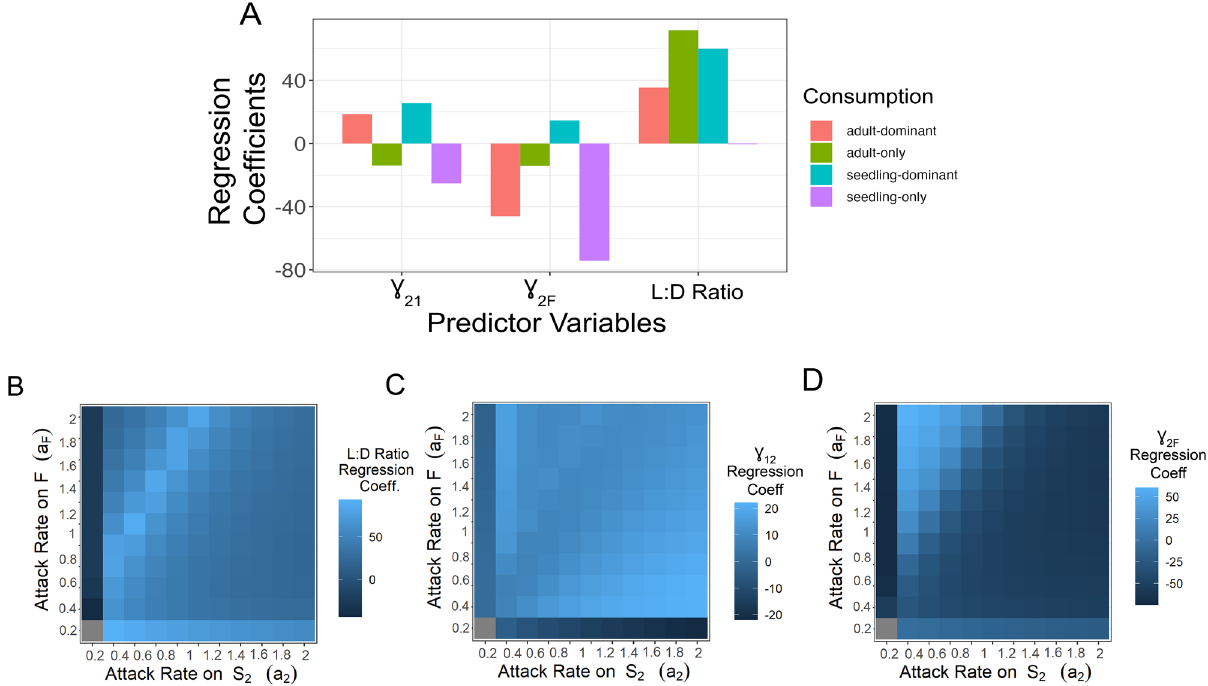
Figure 4. Ecological drivers of stability. Ecological factor effects on stability via coefficients from partial least squares regression of ecological factors versus maximum eigenvalue. Regressions are run for multiple herbivory allocations. ( A ) Bar graph showing specific changes in effect on maximum eigenvalue (regression coefficients) for each ecological factor across the four specific herbivory allocations investigated in-depth in the “Results”. ( B – D ) Range of effects for each ecological factor on stability shown via heatmaps of regressions coefficients on maximum eigenvalue across all specific combinations of herbivory on the adult and seedling stages. Note, the gray square when both attack rates are set to 0 indicates no data given the lack of